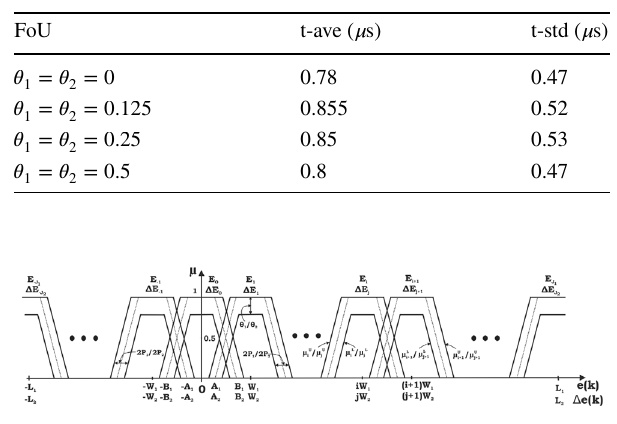
Table 5 Average time and standard deviation time with one million runs